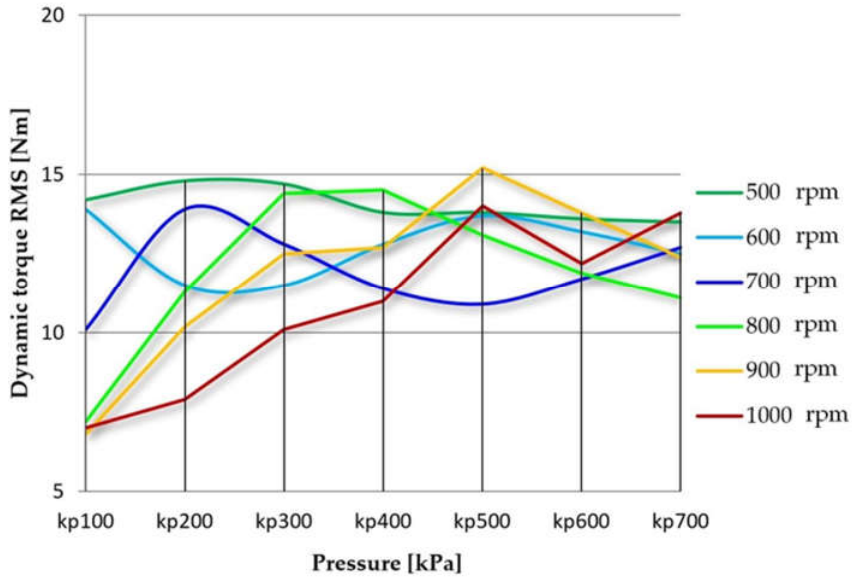
Figure 14. Measurement during constant operating speed with two-cylinder deactivation.